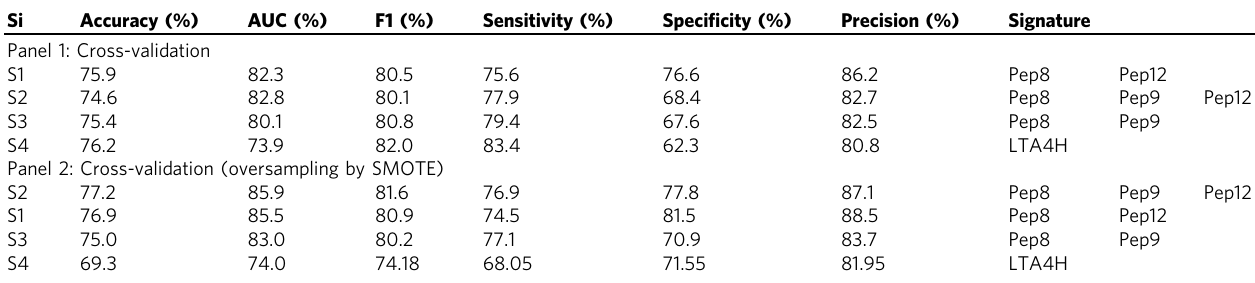
Fig. 7 Prognostic signature in saliva distinguishes OSCC patients. a Work fl ow for machine-learning approach to measure the predictive power of peptides and proteins. b , c The predictive relevance of individual proteins and peptides to distinguish N0 from N + patients is represented by a bar chart indicating their cross-validation ROC AUC (100 repetitions of strati fi ed tenfold cross-validation). The most relevant protein and peptide ordered by the AUC is LTA4H and Pep8_LTA4H, respectively. When only the AUCs of the individual signatures (size 1) are considered, the three highest areas at the protein level are LTA4H (73.9%), COL6A1 (62.1%), and ITGAV (60.5%) and at the peptide level are Pep12_CSTB (73.5%), Pep8_LTA4H (72.8%), and Pep9_COL6A1 (71.0%). d Cross-validation estimated ROC curves of the best protein and peptide signatures. e Box plots representing the AUC of all possibilities of signatures for both imbalanced and balanced (SMOTE) cross-validation. At the peptide level, 1024 signatures were tested. At the protein